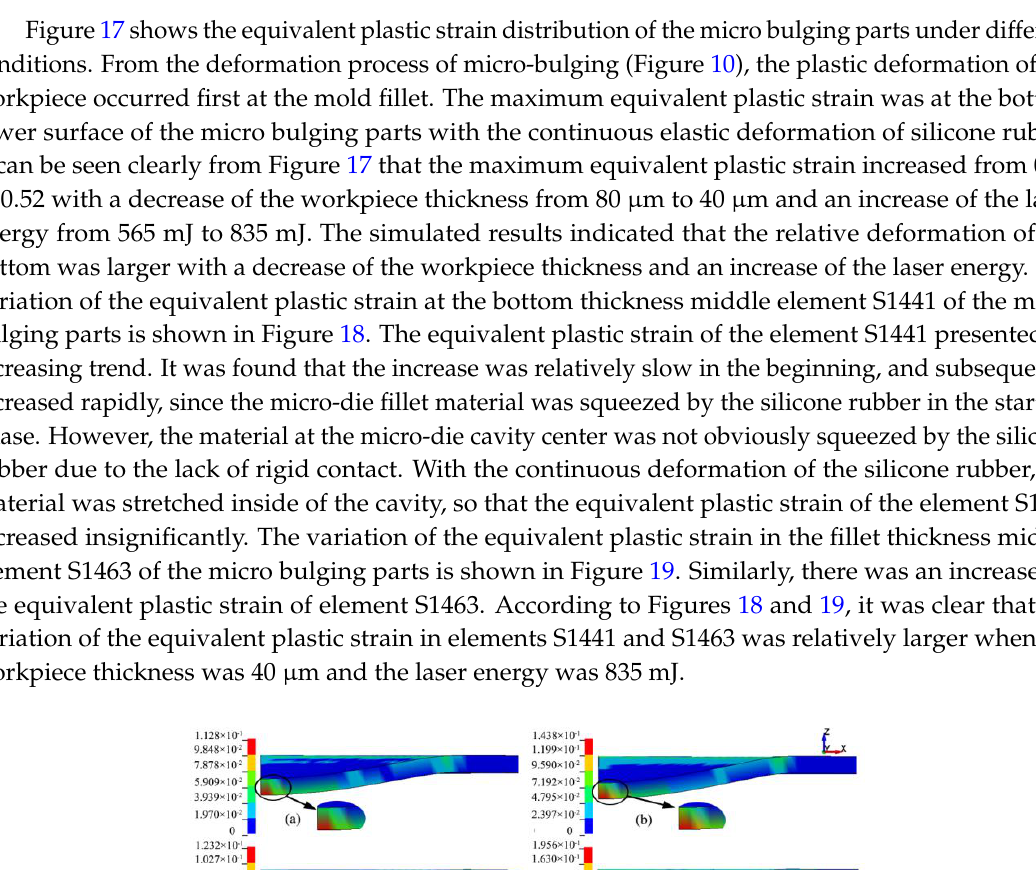
Figure 16. The equivalent stress distribution of micro bulging parts under different conditions: ( a ) 80 µm, 565 mJ ( b ) 80 µm, 835 mJ ( c ) 60 µm, 565 mJ ( d ) 60 µm, 835 mJ ( e ) 40 µm, 565 mJ ( f ) 40 µm, 835 mJ.